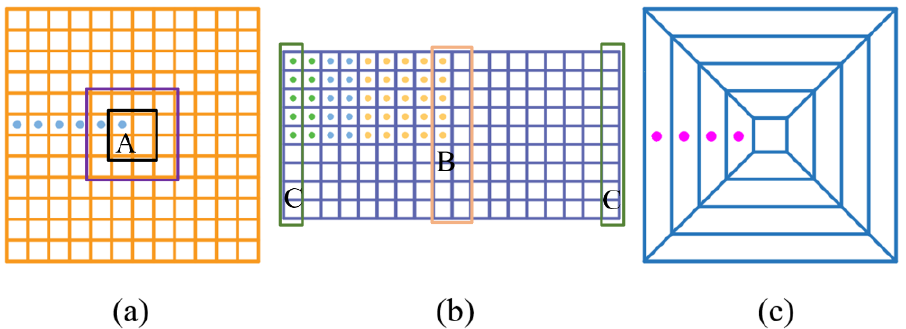
Figure 4. Distribution of measuring points in tuyere. ( a ) SGD; ( b ) RGD; ( c ) SCD. (A, B, and C represent the area circled in the box).